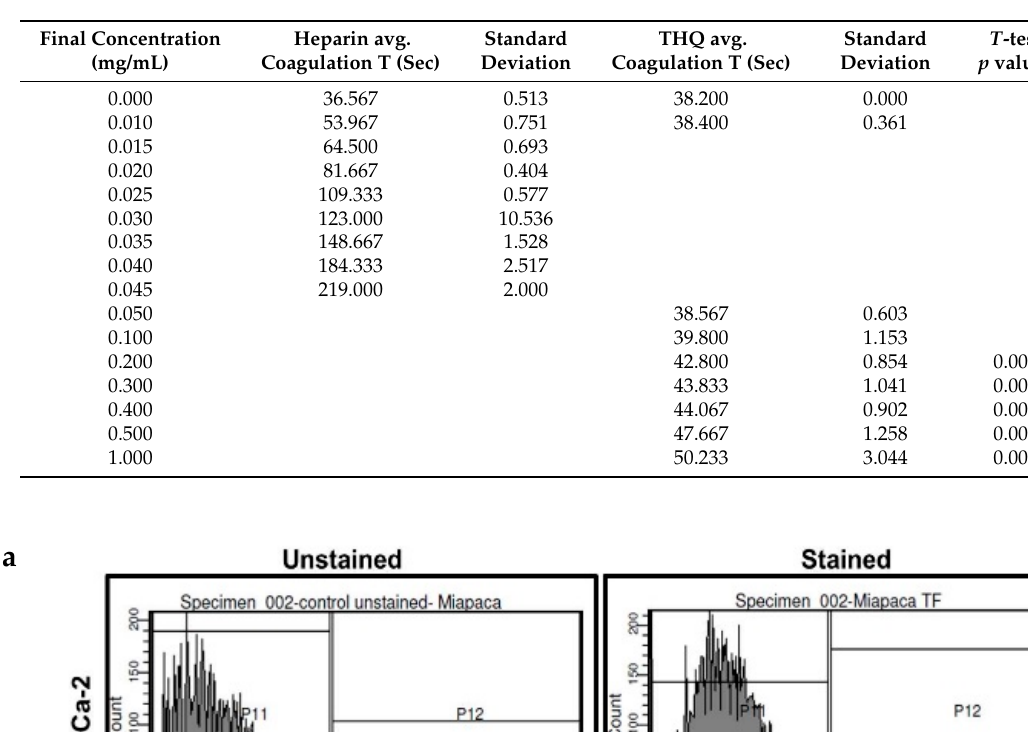
Table 1. Comparison of coagulation times between USP heparin and Thymoquinone (THQ) by aPTT assay.